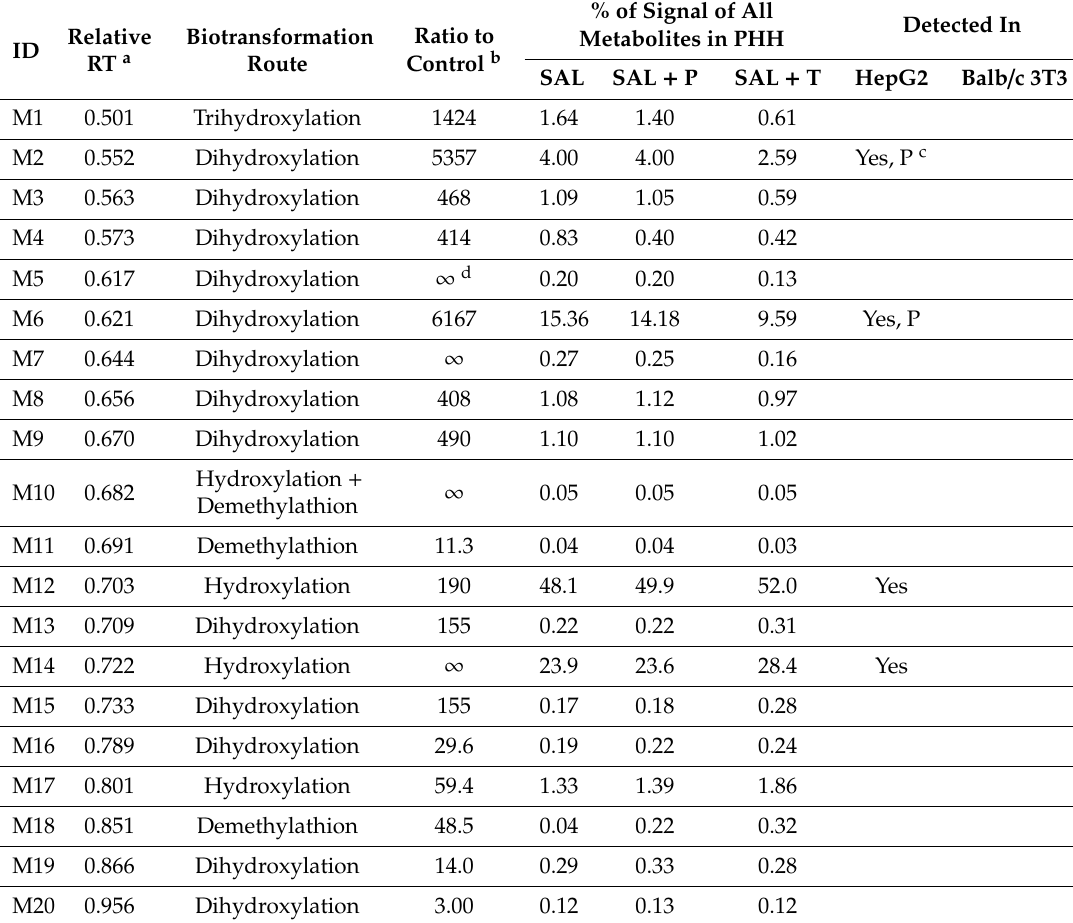
Table 2. Potential metabolites of salinomycin identified in the medium of the primary human hepatocytes